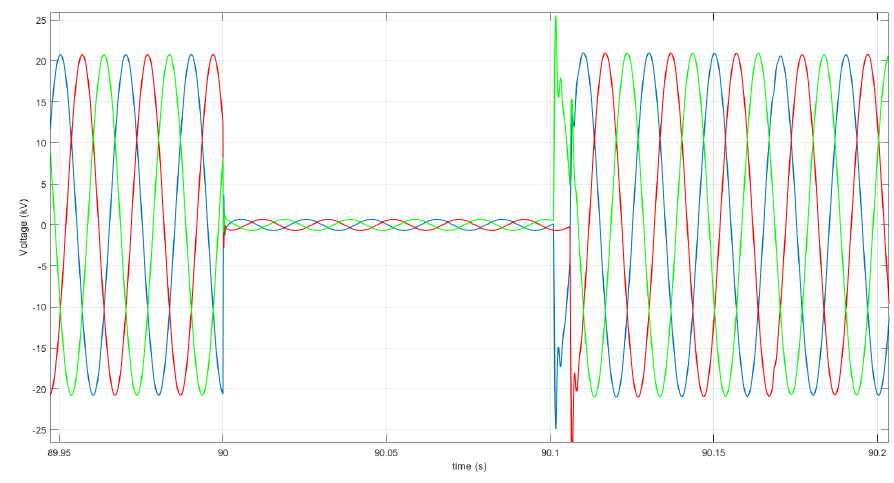
Figure 20. Voltage at bus 1 in response to the three phase short-circuit.